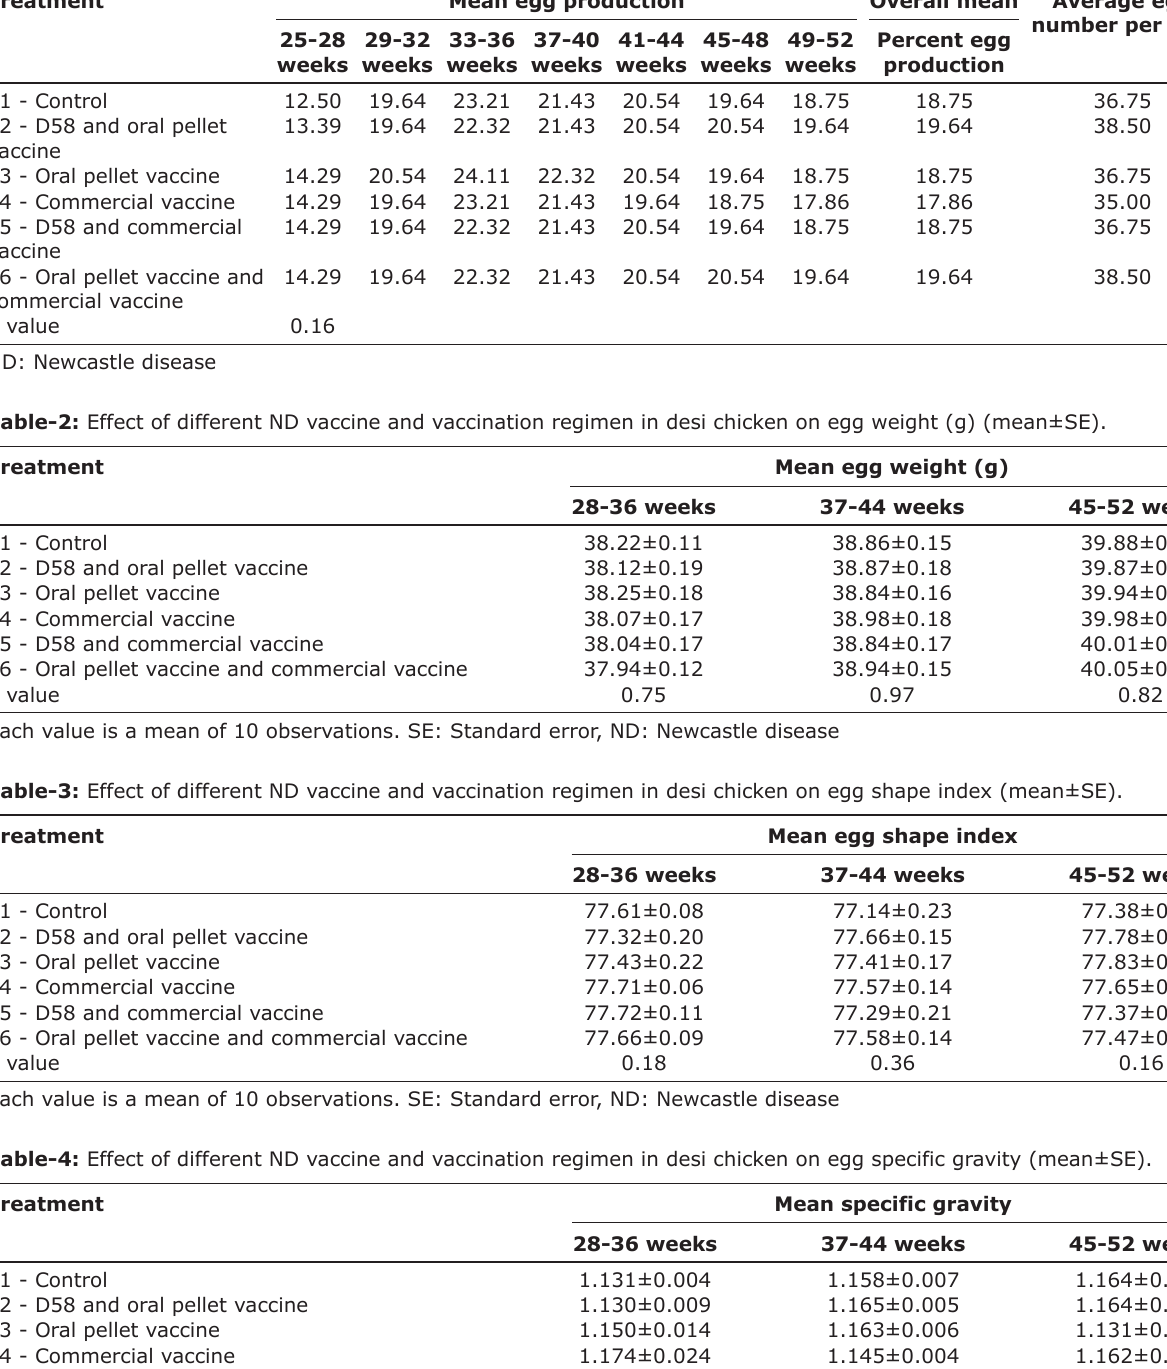
Table-1: Effect of different ND vaccine and vaccination regimen in desi chicken on percent hen day egg production. Treatment